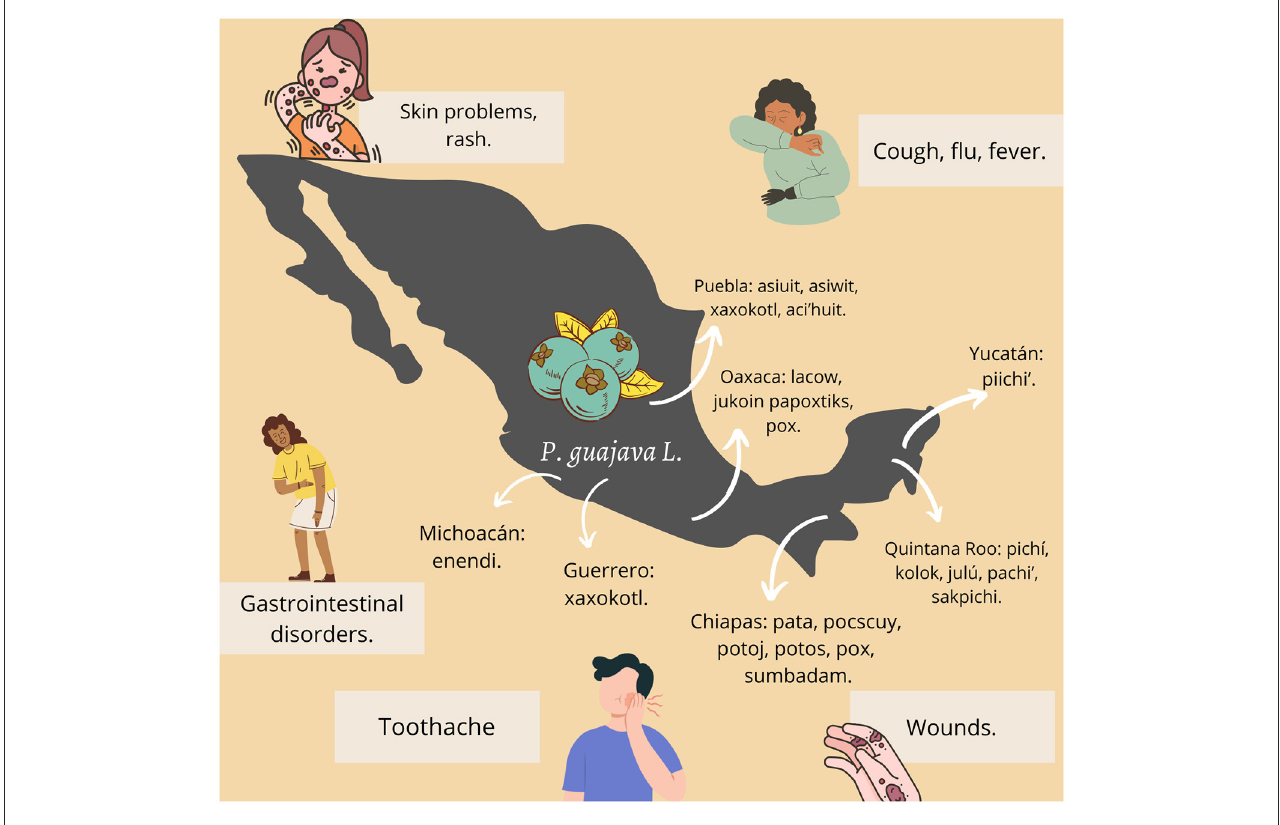
FIGURE3 Traditional uses and names of guava in different states of